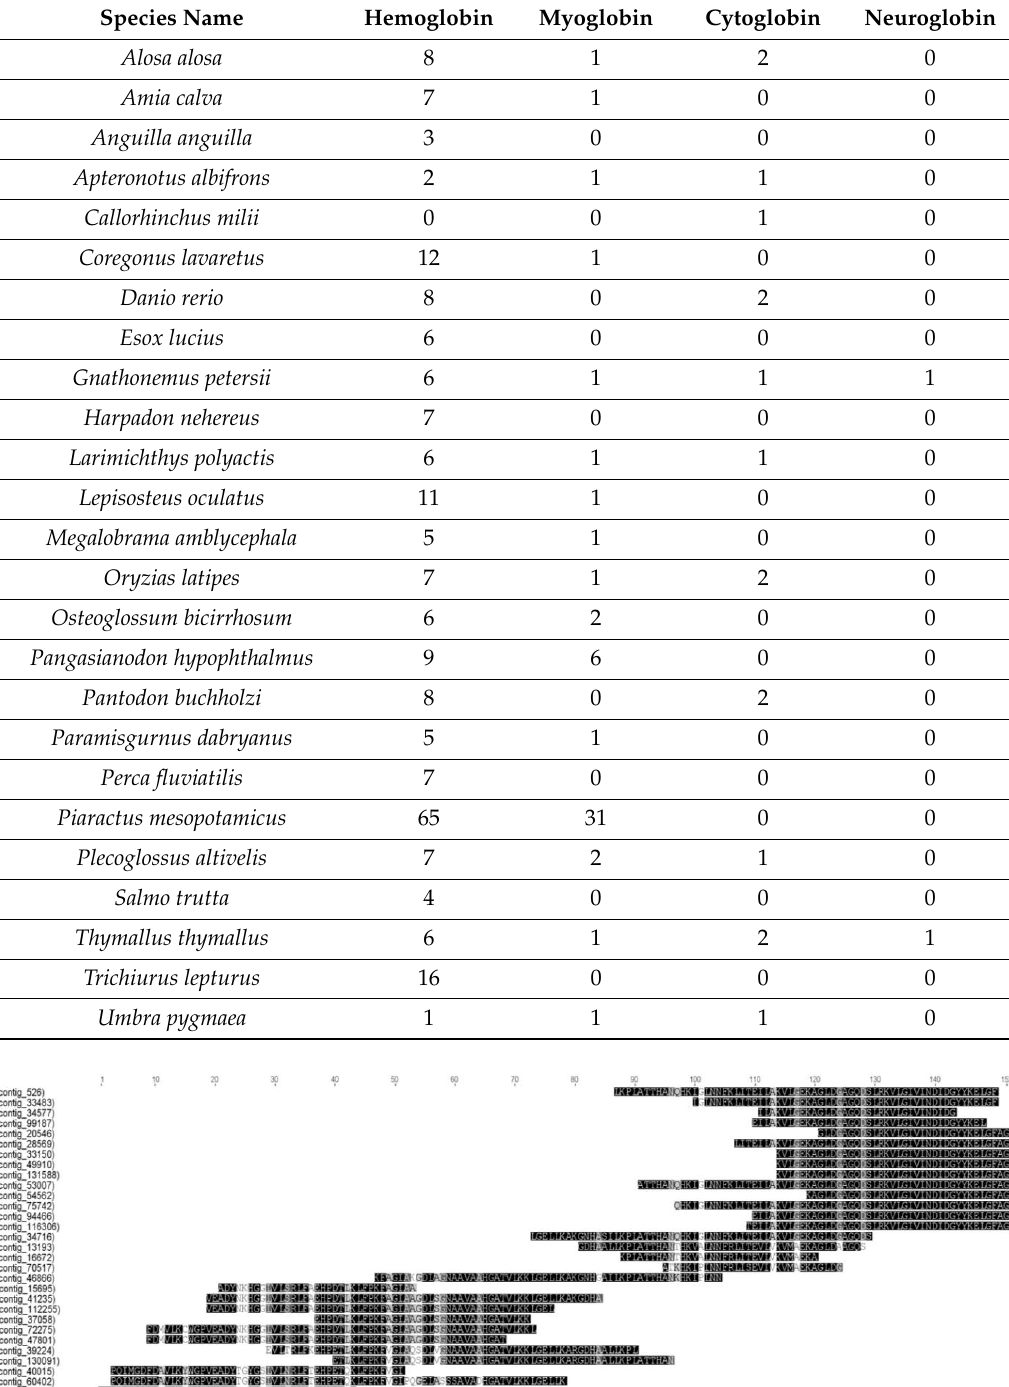
Table A1. Summary of the assembled contigs annotated as transcripts of oxygen-binding protein genes in 25 fish species.